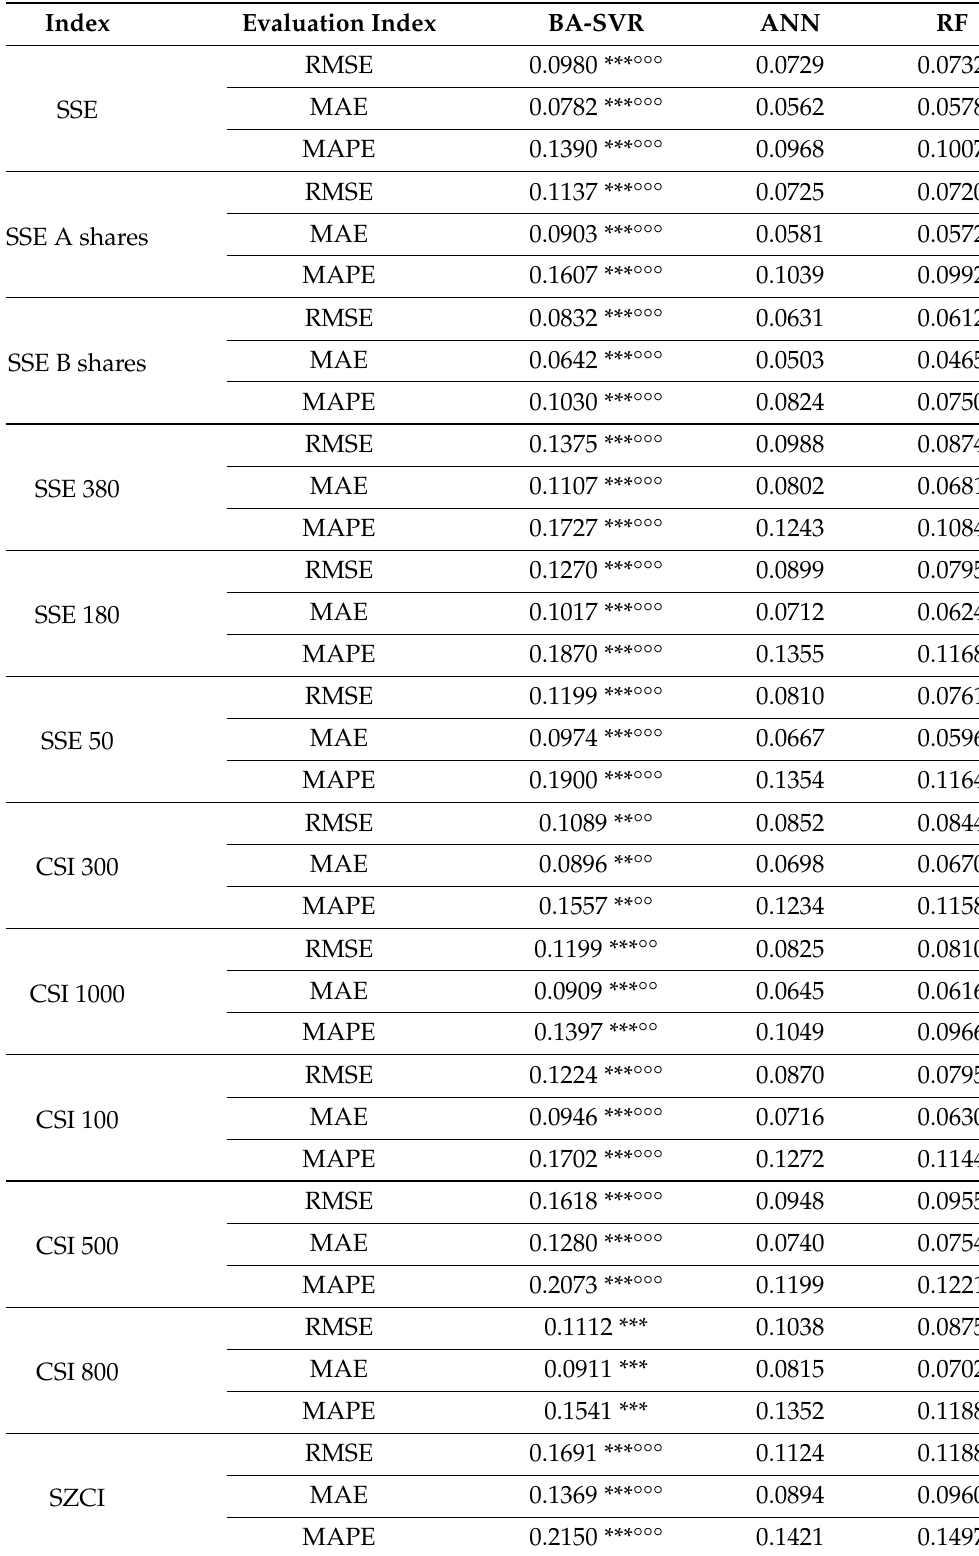
Table 16. The 60-day mid-term forecast effect of 18 stock